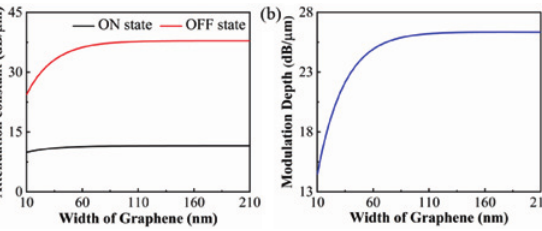
Figure 8: (a) Changes of α at ‘ ON ’ and ‘ OFF ’ states, and (b) modulation depth with the increase of the width of graphene.